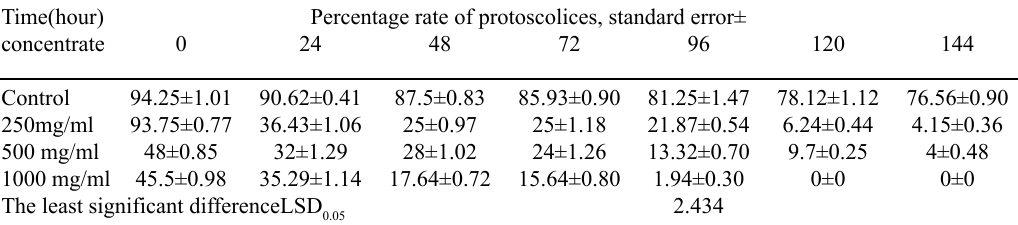
table 5. The percentage of the viability of the protoscolices after exposure to different concentrations of albendazolefor difrent times periods in vitro Percentage rate of protoscolices, standard